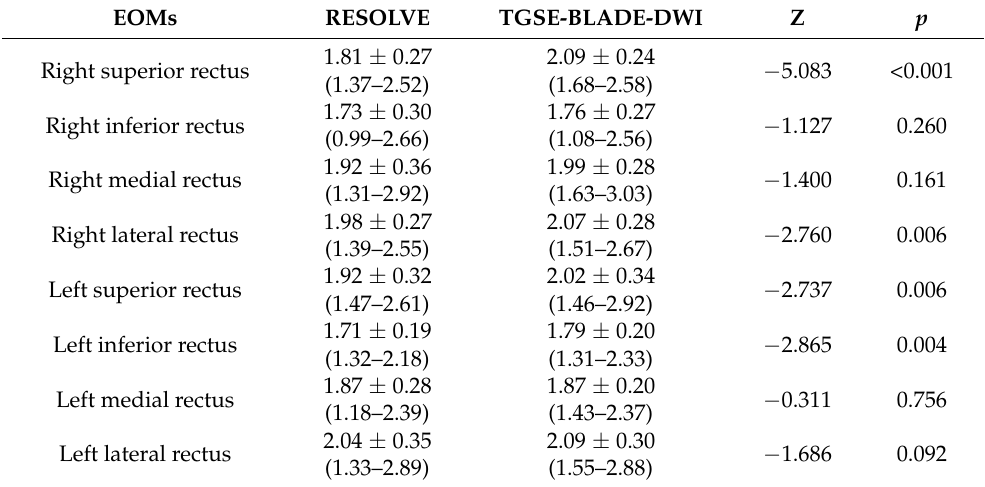
Table 2. Comparison of ADC values of RESOLVE and TGSE-BLADE-DWI in EOMs ( × 10 − 3 mm 2 /s).